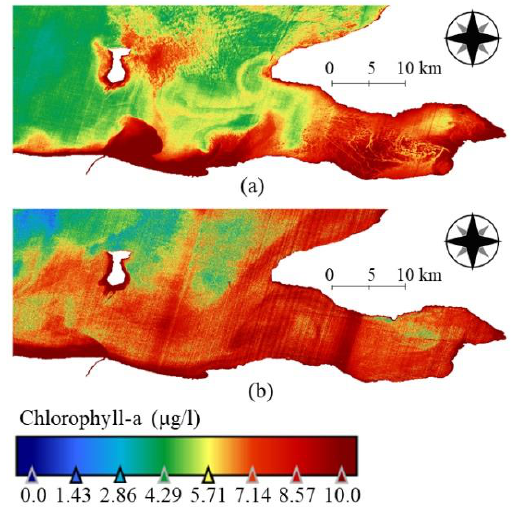
Figure 6. The distribution of chlorophyll-a concentration that retrieved by using a) Landsat 8 satellite data (2018), b) HLS